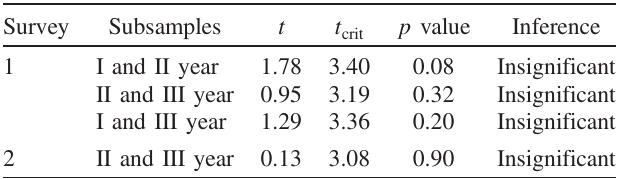
TABLE III. Pairwise t tests between epistemic scores of students grouped by year of study.